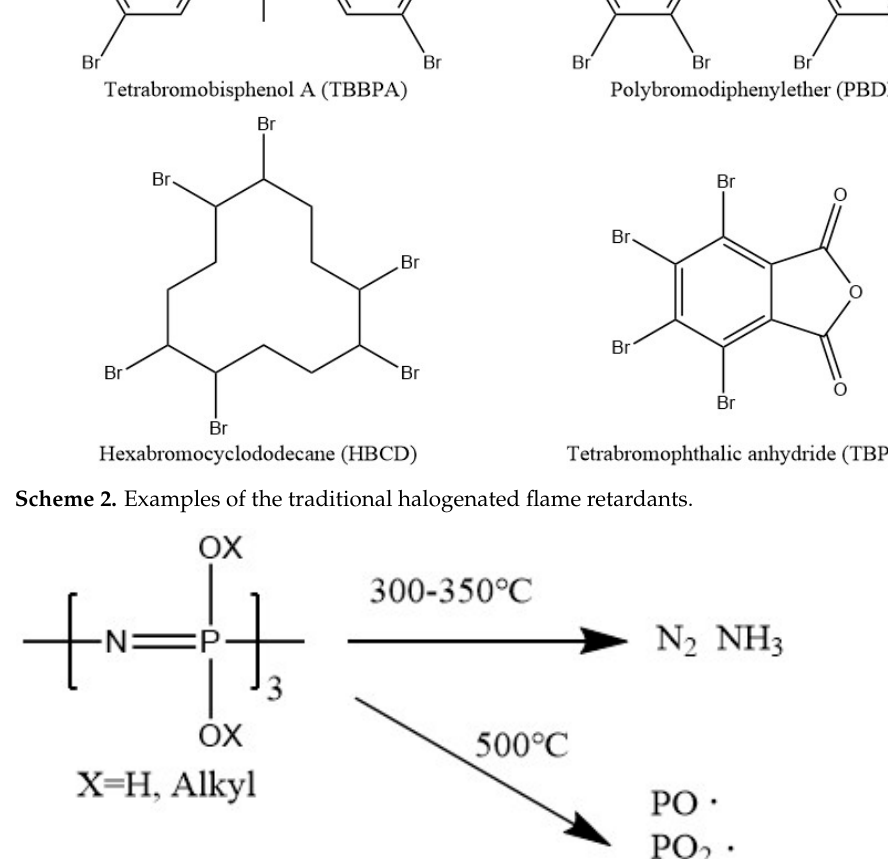
Scheme 3. Representation of the decomposition products for cyclophosphazene [119].